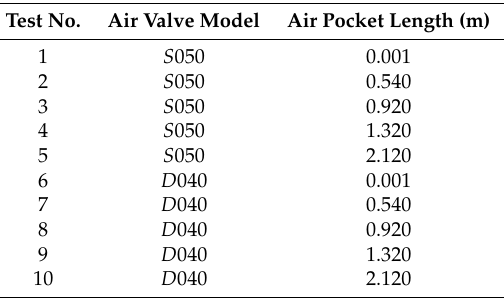
Table 1. Characteristics of tests.